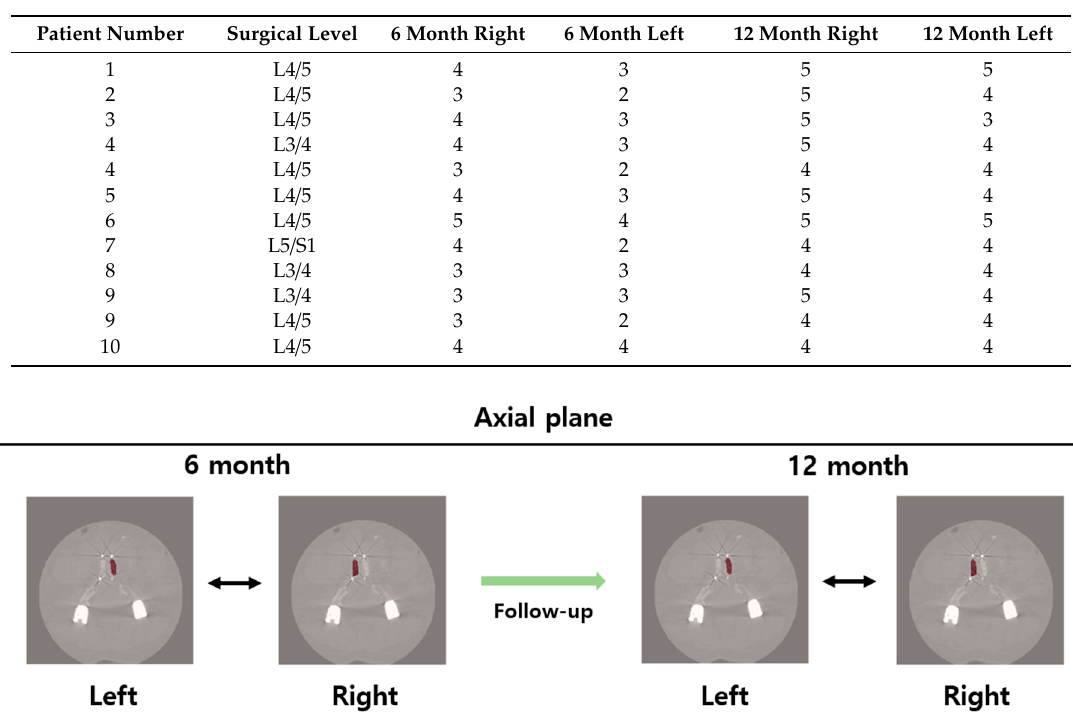
Table 2. Assessment of fusion grade by Brantigan–Ste ff ee classification.